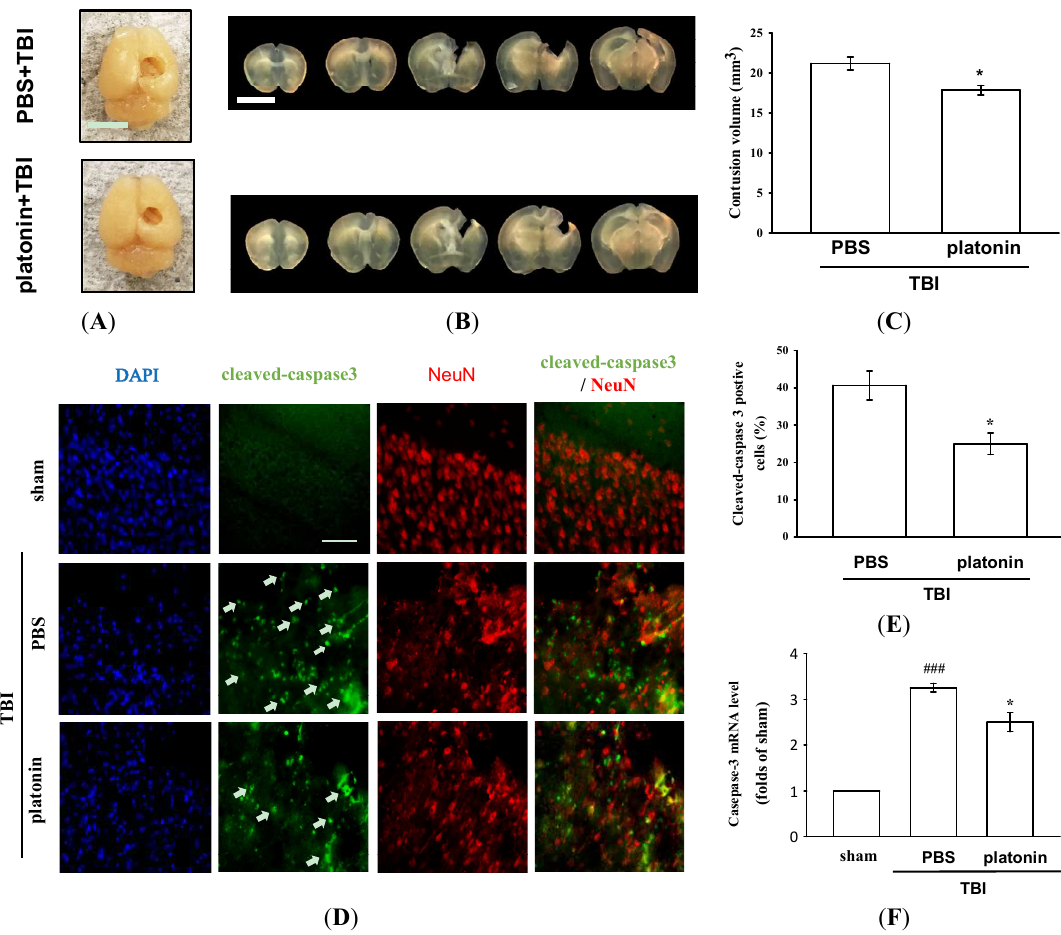
Figure 2. Mitigation of TBI-induced brain contusion volume and caspase-3 activation by platonin treatment in mice. ( A ) The photos represent the TBI impact location and exterior of brains of vehicle- (phosphate-buffered saline (PBS), ip) and platonin-treated (200 µg/kg, ip) mice on the 28th day after the TBI. The white bar indicates 5 mm. ( B ) Coronal brain sections (1 mm thick) showing the lesion volume, and quantitative analytical results are illustrated ( C ). The white bar indicates 5 mm. Data are presented as the mean ± SEM ( n = 4). * p < 0.05, compared to the PBS group. ( D , E ) Mice were treated with the isovolumetric solvent control (PBS, ip) or platonin (200 µg/kg, ip) for 30 min and then subjected to TBI. The expression of cleaved-caspase-3 and NeuN was determined at 24 h after the impact by fluorescence microscopy as described in “Materials and Methods.” Fluorescence images are typical of those obtained in three separate experiments demonstrating caspase-3 activation (arrows) near the lesion portion in mice subjected to the TBI. Blue depicts the nucleus, green depicts cleaved caspase-3, and red depicts NeuN. The white bar indicates 75 µm. ( F ) The mRNA from contralateral brain homogenates at 24 h after TBI subjected to an RT-qPCR assay. Data are presented as the mean ± SEM ( n = 6). ### p < 0.001, compared to the sham group; * p < 0.05, compared to the PBS group.